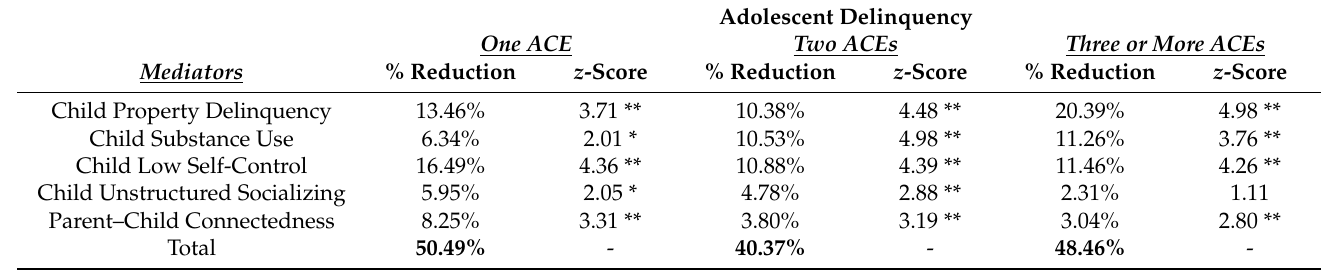
Table 3. KHB Test of Mediators between ACE Exposure and Adolescent Delinquency ( N =